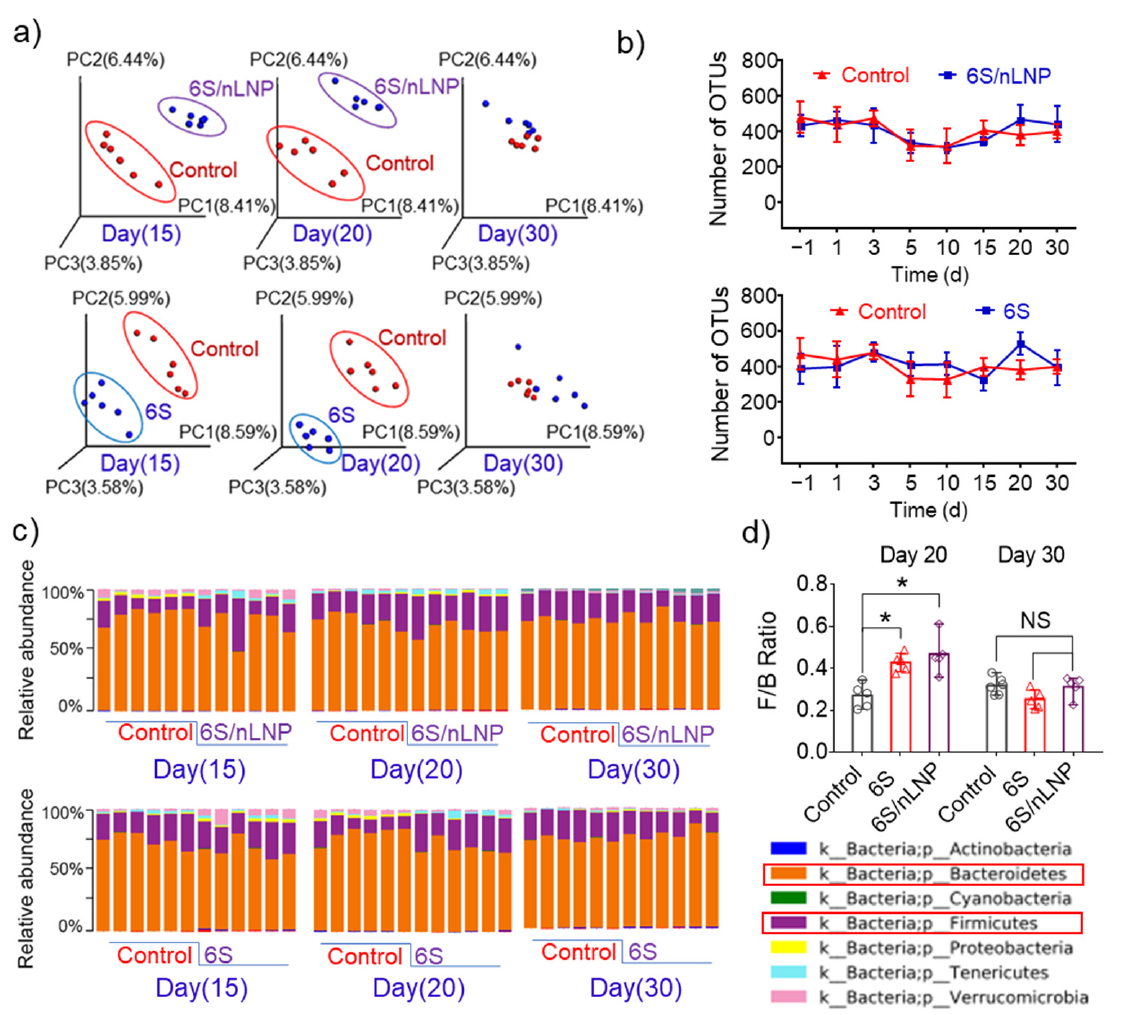
Figure 4. The diversity of microbiota is not affected by free 6S or 6S/nLNP treatment. ( a ) PCoA analysis of microbiota in mice treated with 6S/nLNP or free 6S relative to control mice (days 15, 20, and 30). ( b ) The number of operational taxonomy units (OTUs) in the microbiota of mice treated with 6S/nLNP or free 6S compared with that in the control group. ( c ) Taxonomic summary at the phylum level (days 15, 20, and 30), and ( d ) F/B ratio of gut microbiota (days 20 and 30) for mice treated with 6S/nLNPs or free 6S versus controls ( n = 6; * p < 0.05, NS: